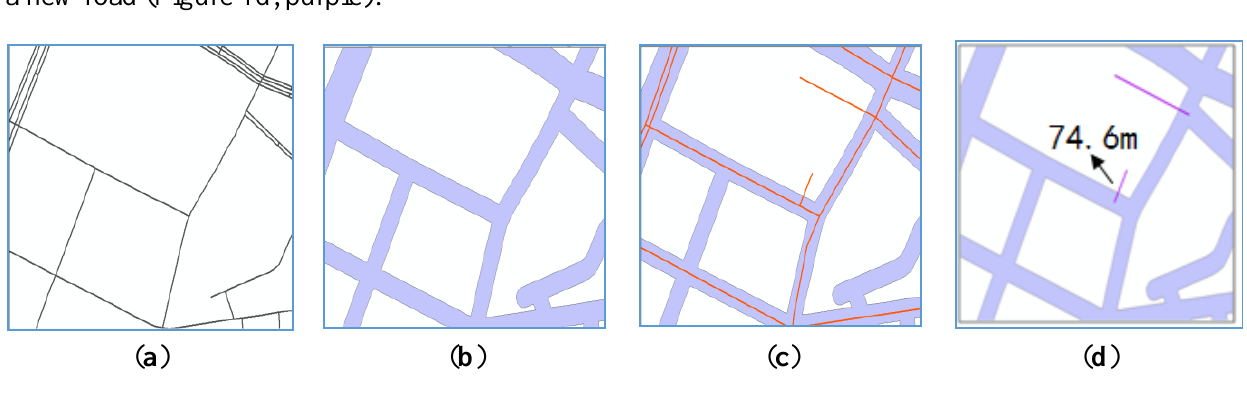
Figure 1. Buffer analysis to find new roads ( a ) Reference; ( b ) Buffed reference; ( c ) OSM roads within the buffer in red; ( d ) Detected new roads in purple.